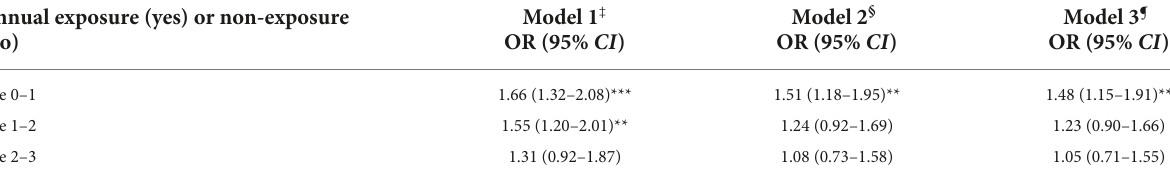
TABLE 3 The relationship between early screen exposure and hyperactive behaviors ( N = 42,841).